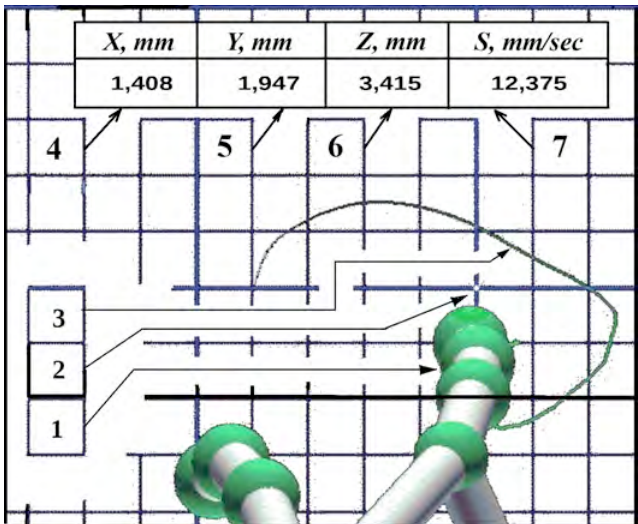
Fig. 2. Visual analyzer of micro movements in interactive model СЕА16